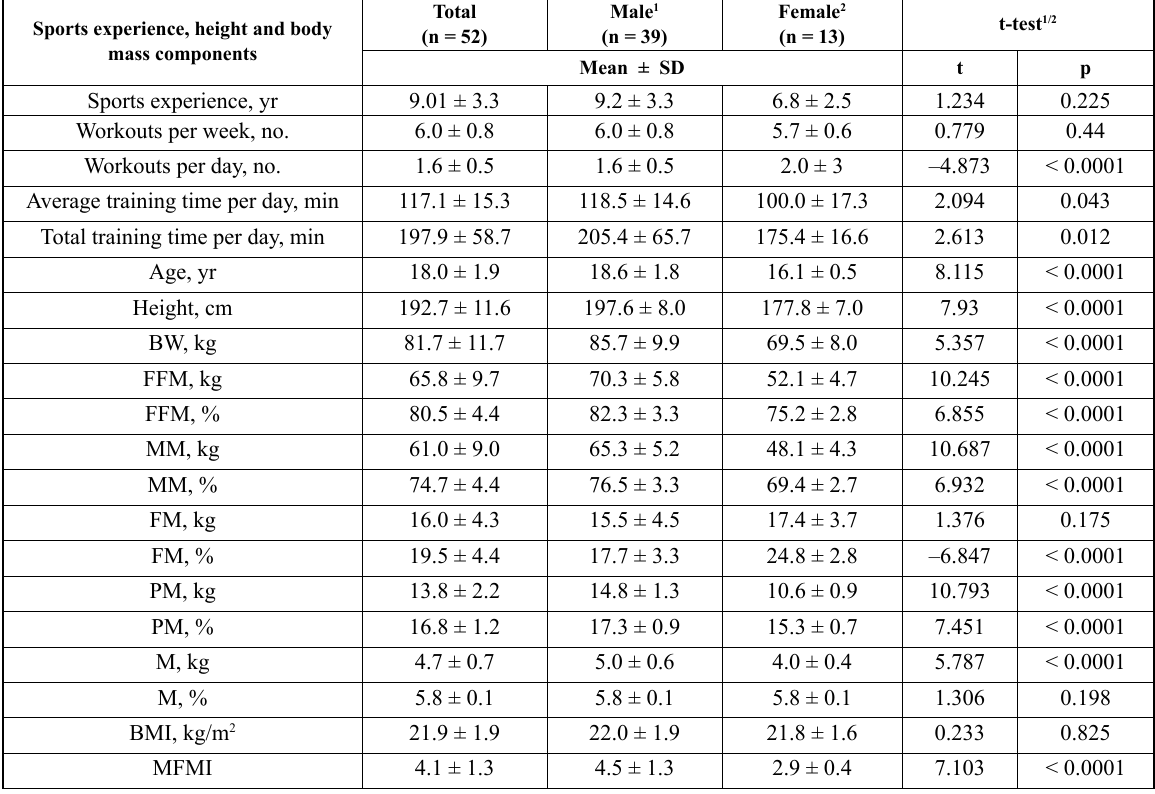
Table 1. Sports experience and anthropometric data of Lithuanian Olympic team basketball players (n = 52) Sports experience, height and body mass